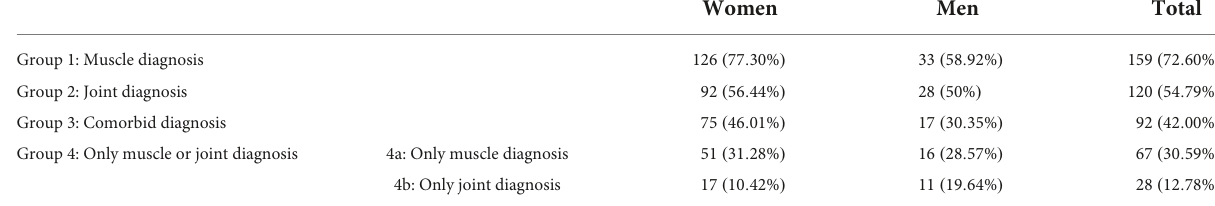
TABLE 2 Distribution of women and men in each